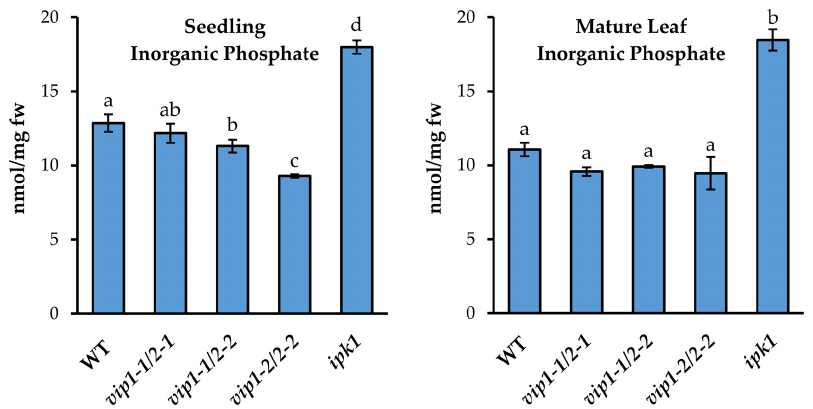
Figure 3. Inorganic phosphate content was quantified in 18-day-old seedlings and in 49-day-old mature leaves of WT, vip double mutants, and ipk1 . Data presented are the average ± SD of three independent bioreplicate experiments. Different letters indicate statistically significant means (Tukey HSD, α =